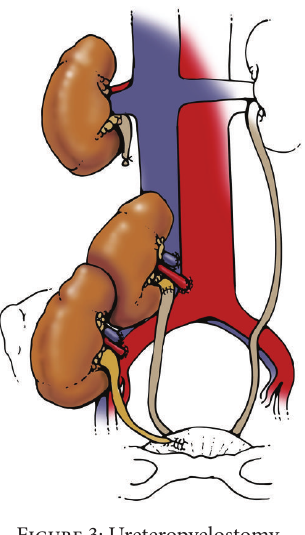
Figure 3: Ureteropyelostomy.